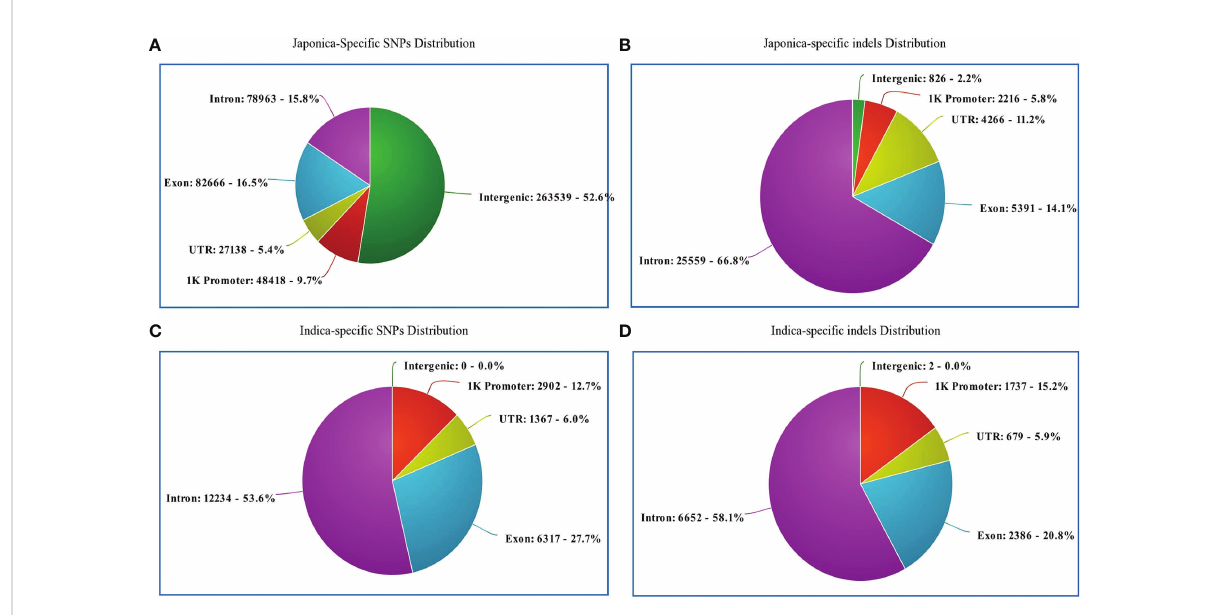
FIGURE 3 Genomic position of selected SNPs and indels. (A) Distribution of japonica-speci fi c SNPs in different genomic regions. (B) Distribution of japonica-speci fi c indels in different genomic regions. (C) Distribution of genomic regions indica-speci fi c SNPs in different genomic regions (D) Distribution of indica-speci fi c indels in different genomic